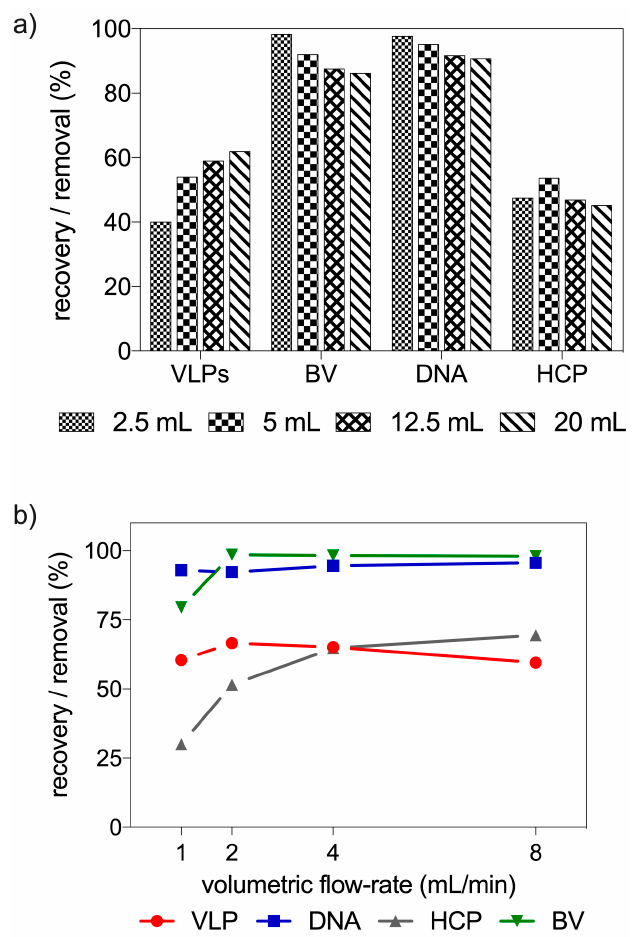
Figure 6. Throughput and residence time optimization in radial-flow columns. ( a ) Effect of different loaded sample volumes (2.5, 5, 12.5 and 20 mL) in radial-flow columns ( n = 1) and ( b ) impact of residence time in VLP recovery and impurity clearance in the radial-flow setup used.